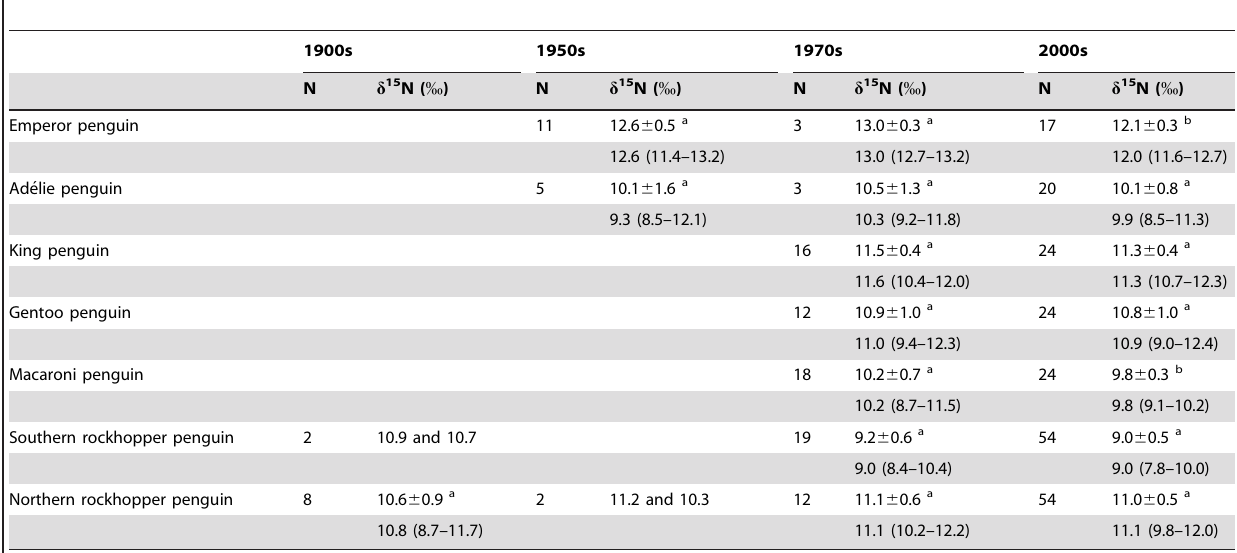
Table 3. Historic (1900s, 1950s, 1970s) and contemporary (2000s) nitrogen isotopic signatures of penguin feathers.